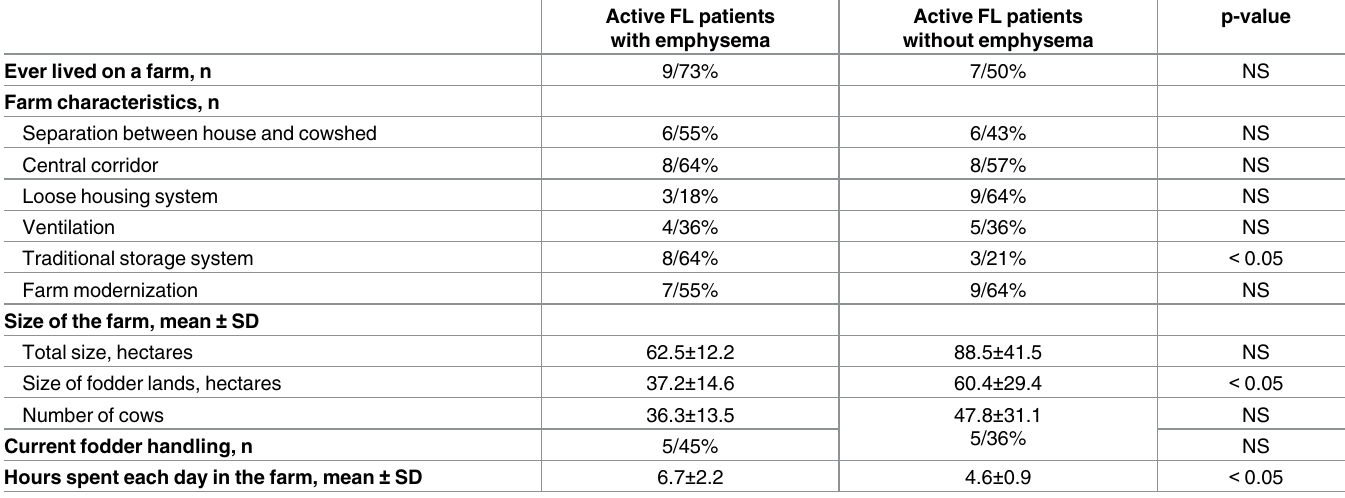
Table 4. Occupational characteristics of patients with active FL *